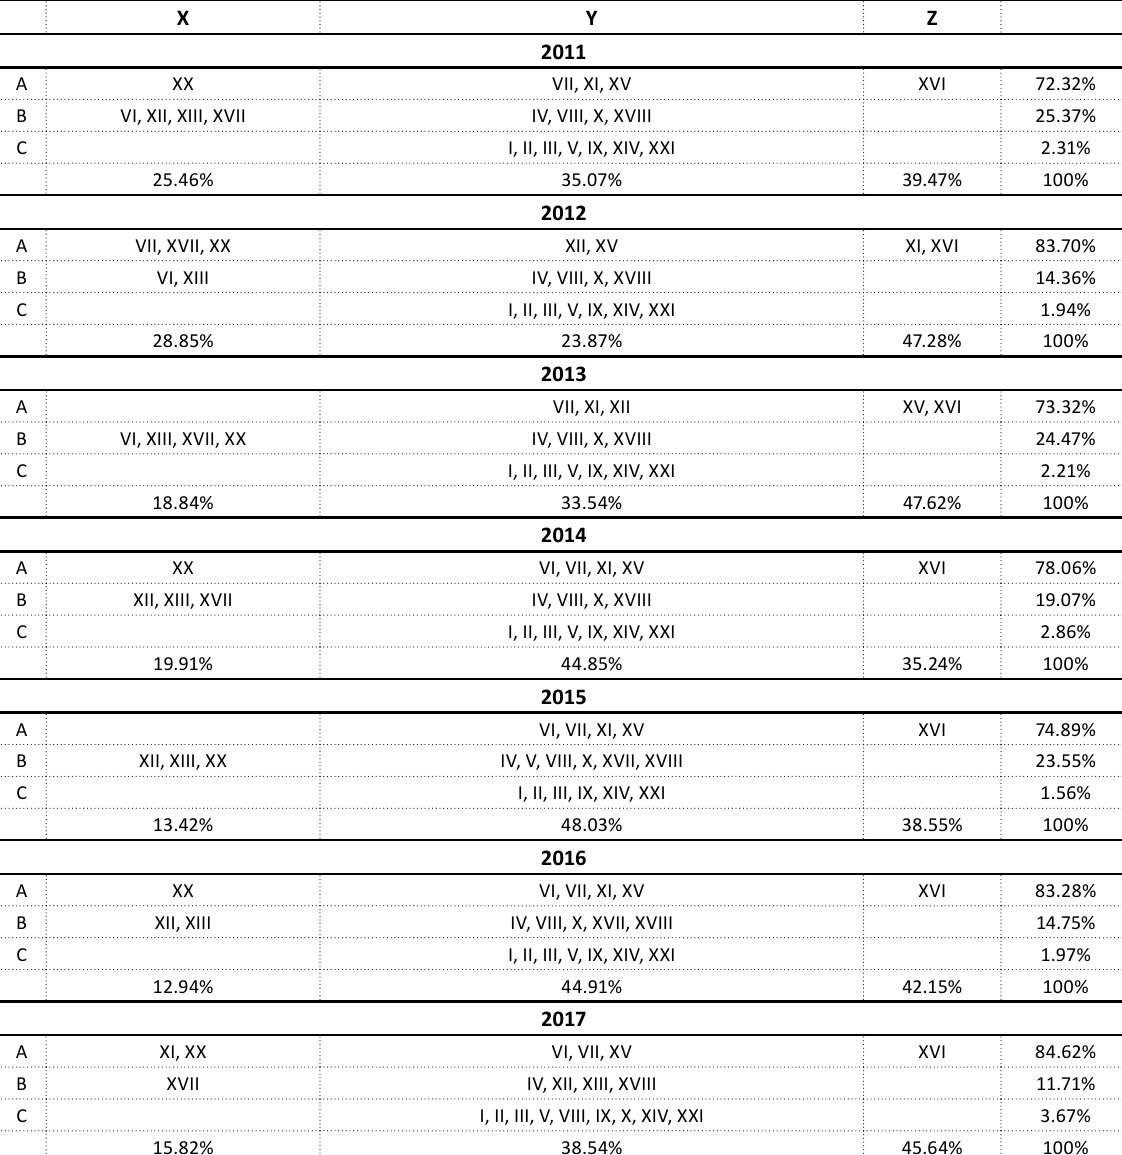
Source: Calculated by the